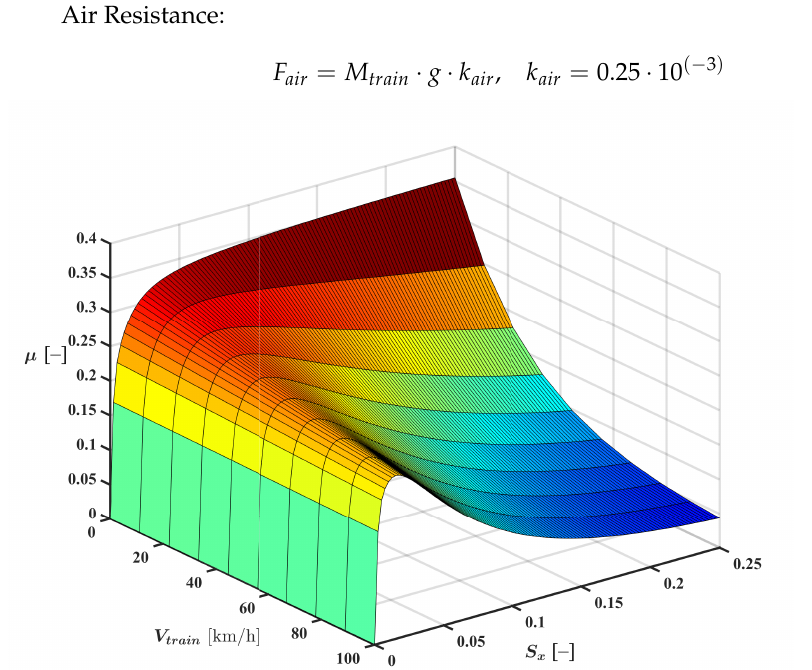
Figure 6. Adhesion characteristics as a function of the driving speed V train and slip S x